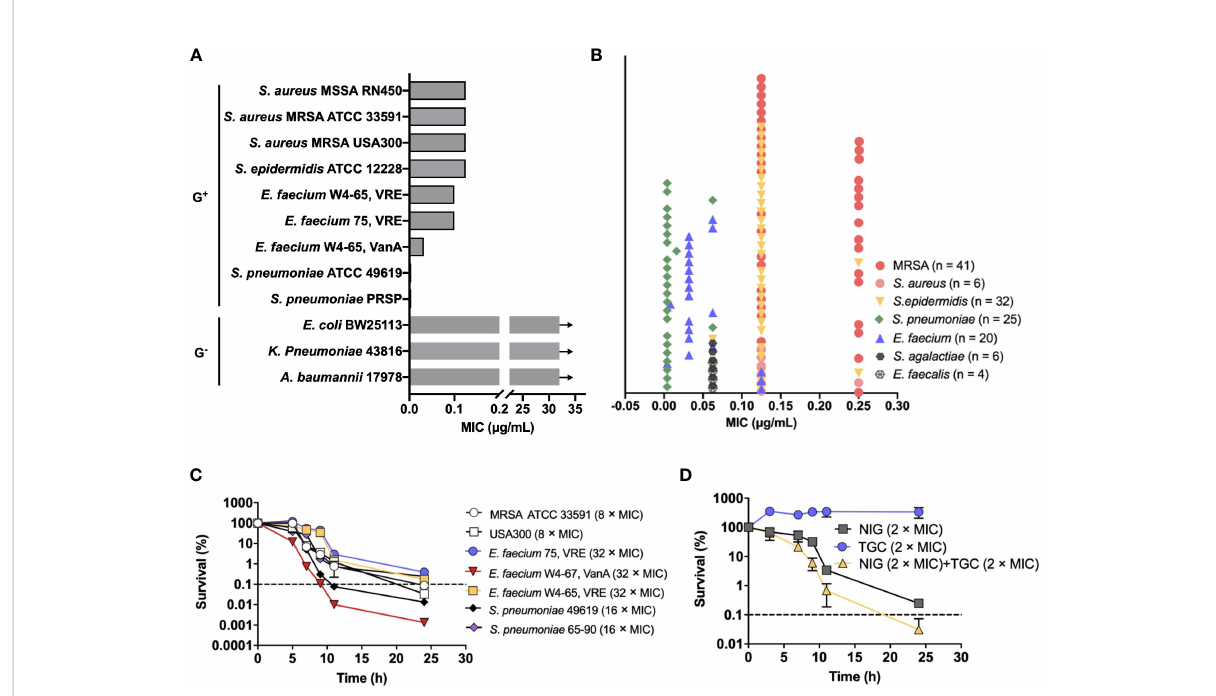
FIGURE 1 Nigericin activity against drug-resistant bacteria. (A) Bacteriostatic activity with selected representative bacterial species. Nigericin MIC is shown for the listed strains of Gram-positive and Gram-negative bacteria. Arrows indicate that the MIC exceeded the highest nigericin concentration tested. (B) Bacteriostatic activity with a collection of 134 drug-resistant clinical isolates. (C) Bactericidal activity. Exponentially growing bacterial cultures were treated with the indicated (after species name in parenthesis) concentrations of nigericin for the indicated times after which percent survival was plotted as a function of treatment time. (D) Synergistic bactericidal activity between nigericin and tigecycline. Exponentially growing S. aureus strain RN450 cultures were treated with the indicated concentrations of Nigericin (NIG), tigecycline (TGC), or the two in combination for the indicated times. (A, B) Similar results were obtained from 3 replicate assays. (C, D) Dashed line indicates 0.1% survival. Data are average of 3 biological replicates; error bars indicate